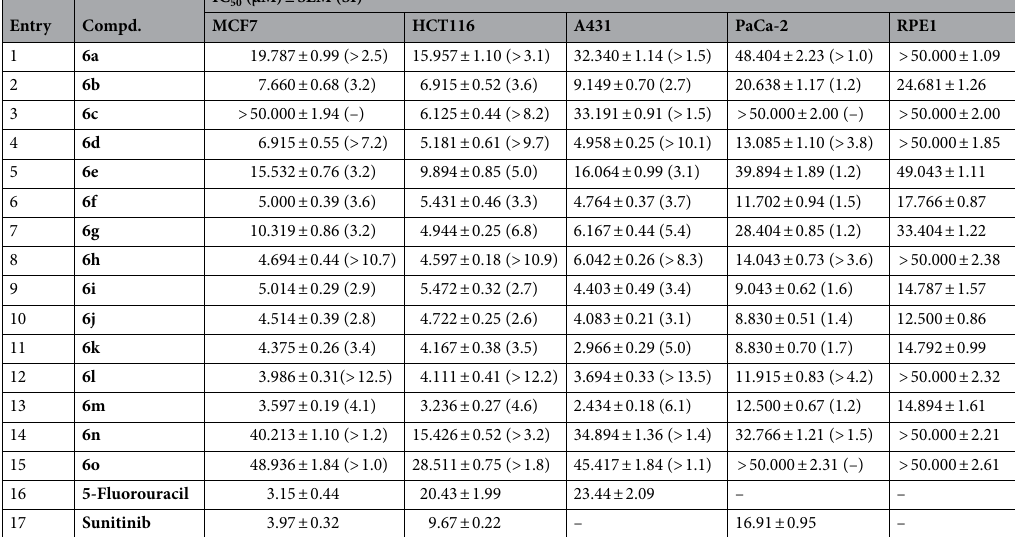
Table 1. Antiproliferation properties of the synthesized spiro-3-indolin-2-ones 6a ‒ o and standard references (5-fluorouracil and sunitinib). a SI (selectivity index)